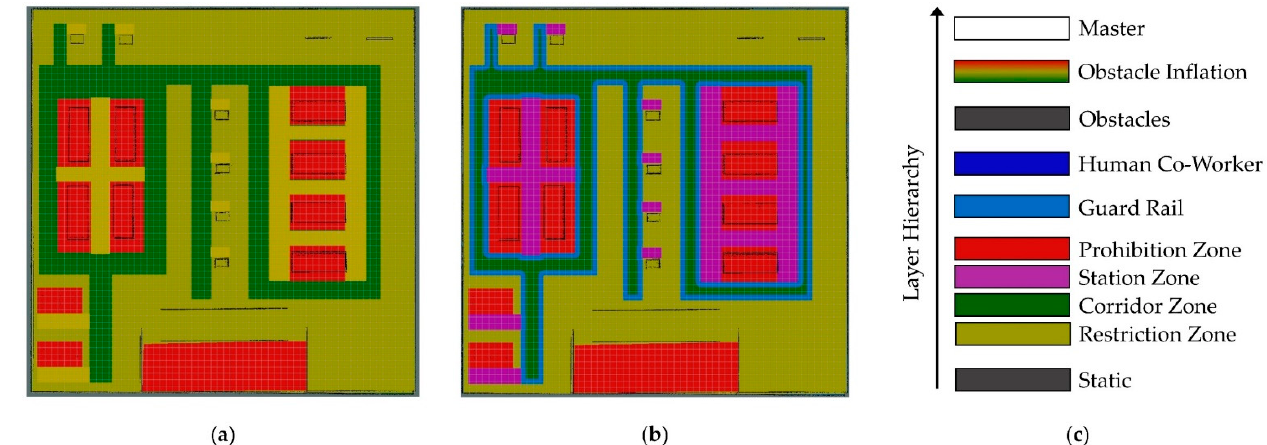
Figure 3. Zone-based segmentation of a production environment. ( a ) Zone-based segmentation of a 60 × 60 m environment colored from green (minimum cost value) to red (maximum cost value); ( b ) same zone setup, but with individual zone colors of layer hierarchy; ( c ) hierarchical ordered costmap layers.